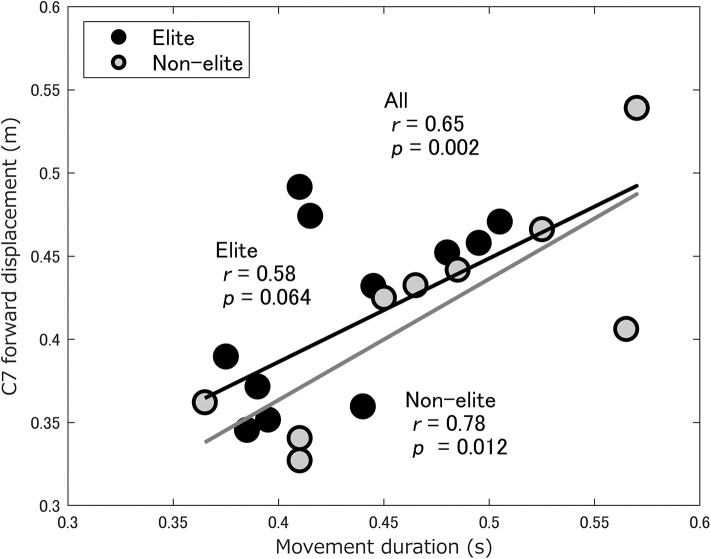
Scatterplot of the movement duration against the C7 forward displacement in the elite (black circles) and non-elite (gray circles) wrestlers. The black line indicates the correlation between the variables among all wrestlers. The gray line indicates the correlation between the variables in non-elite wrestlers.